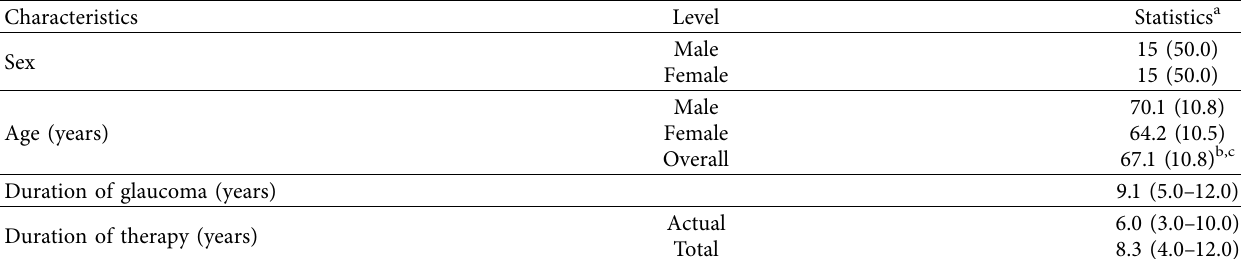
Table 1: Patients’ characteristics at the baseline.